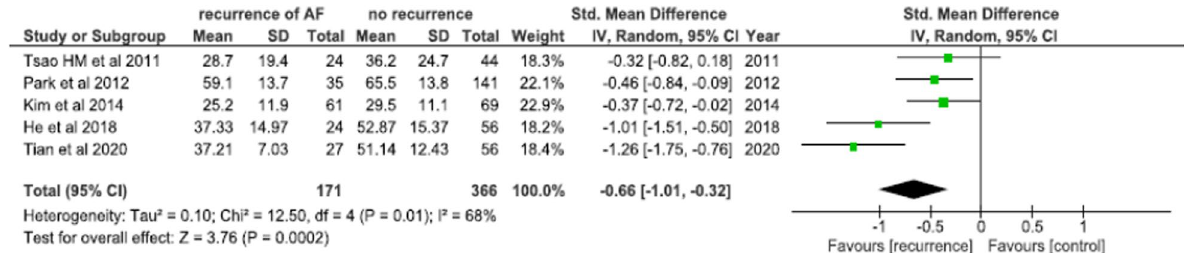
Fig. 2 Mean difference in LAA ejection fraction between arrhythmia recurrence and arrhythmia free